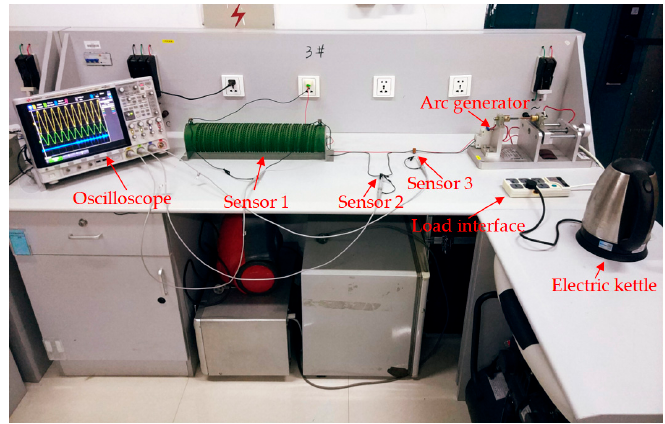
Figure 18. Physical diagram of the series arc fault experimental simulation system.